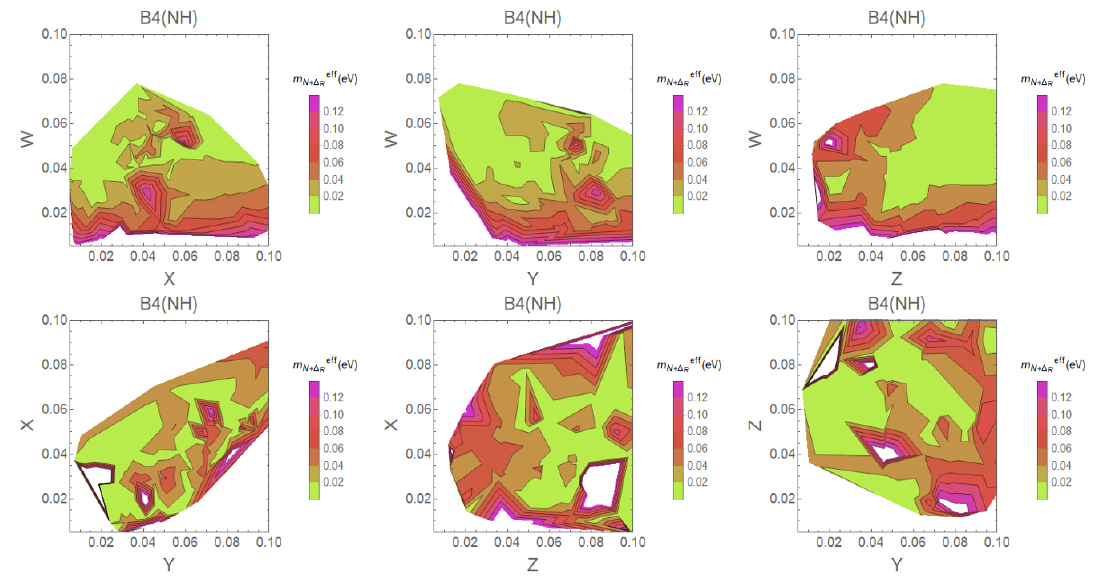
Figure 18 . The various combinations of type II SS model parameters (in eV) with the new physics contribution to e(cid:11)ective mass as the contour, where 0.061 eV is the KamLAND-Zen upper limit in B4 class of two texture zero neutrino mass matrix for normal hierarchy. Figure 19 . The various combinations of type II SS model parameters (in eV) with the new physics contribution to e(cid:11)ective mass as the contour, where 0.061 eV is the KamLAND-Zen upper limit in B4 class of two texture zero neutrino mass matrix for inverted